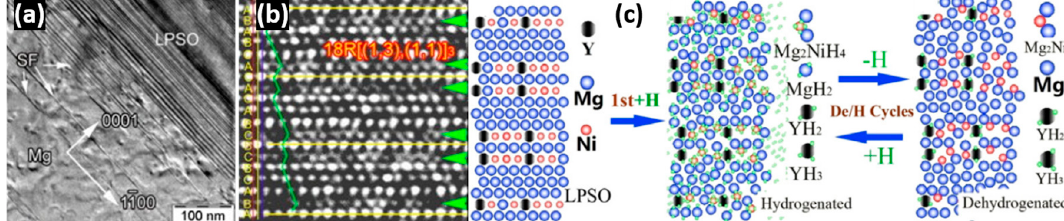
Figure 6. Original microstructure and H-induced local composition changes in a Mg-Ni-Y alloy that contains the 18R-LPSO phase. ( a ) Bright field TEM image showing the 18R-LPSO phase in proximity to Mg; stacking faults (SF) in Mg are indicated by arrows. ( b ) High resolution TEM of the 18R-LPSO phase; the staking sequence of close-packed planes is indexed. ( c ) The LPSO structure is irreversibly lost during the first H absorption, which leads to a fine dispersion of MgH 2 , Mg 2 NiH x , and YH x nanocrystallites (see text for detailed explanation). Reprinted with permissions from [71] (copyright 2013 Elsevier).